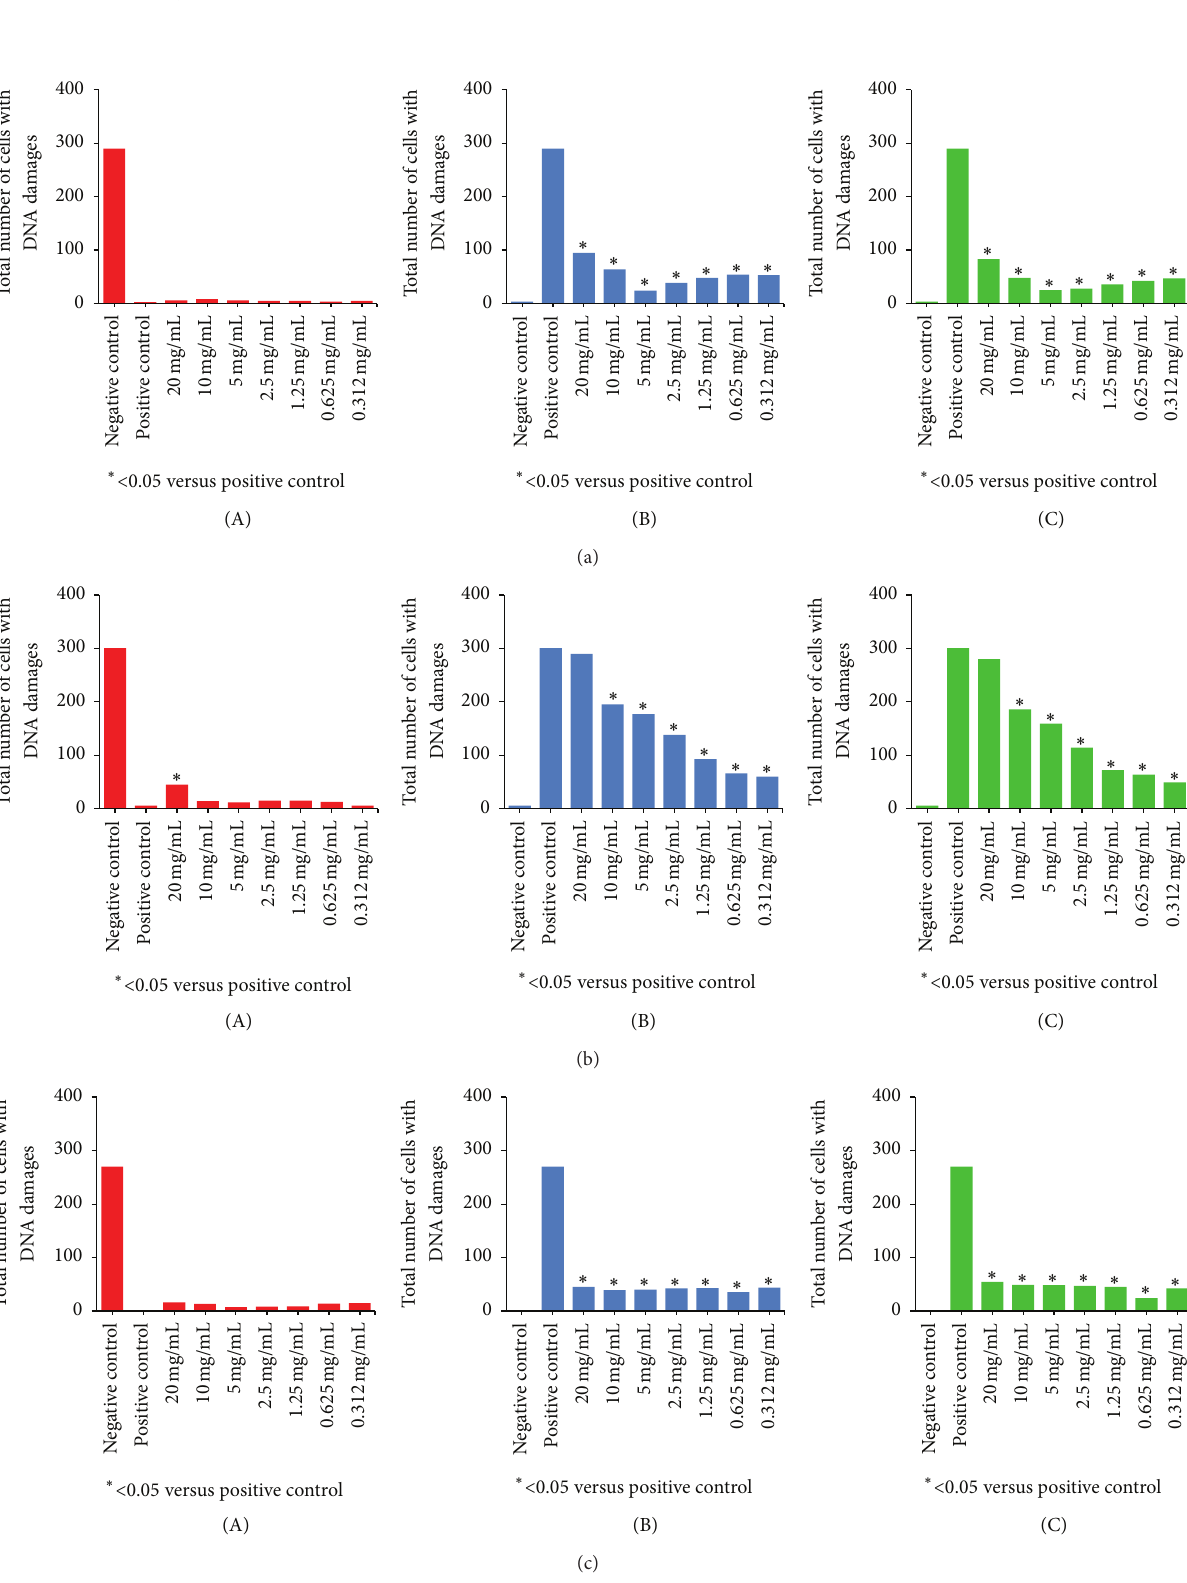
Figure 2: Effect of fruiting body extracts of (a) Trametes versicolor, (b) T. hirsuta, and (c) T. gibbosa : (A) genotoxic, (B) antigenotoxic, pretreatment, and (C) antigenotoxic, posttreatment. Three independent experiments with three replicates per experiment were done and evaluated by comet assay. 100 nuclei per each replicate were analyzed. Data represent total number of cells with DNA